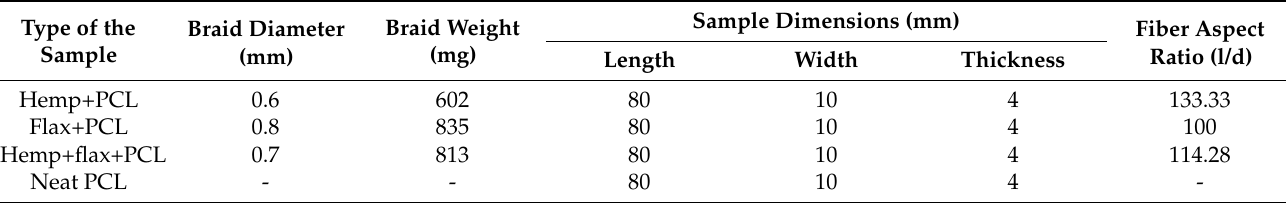
Table 3. Types of samples produced for Charpy impact